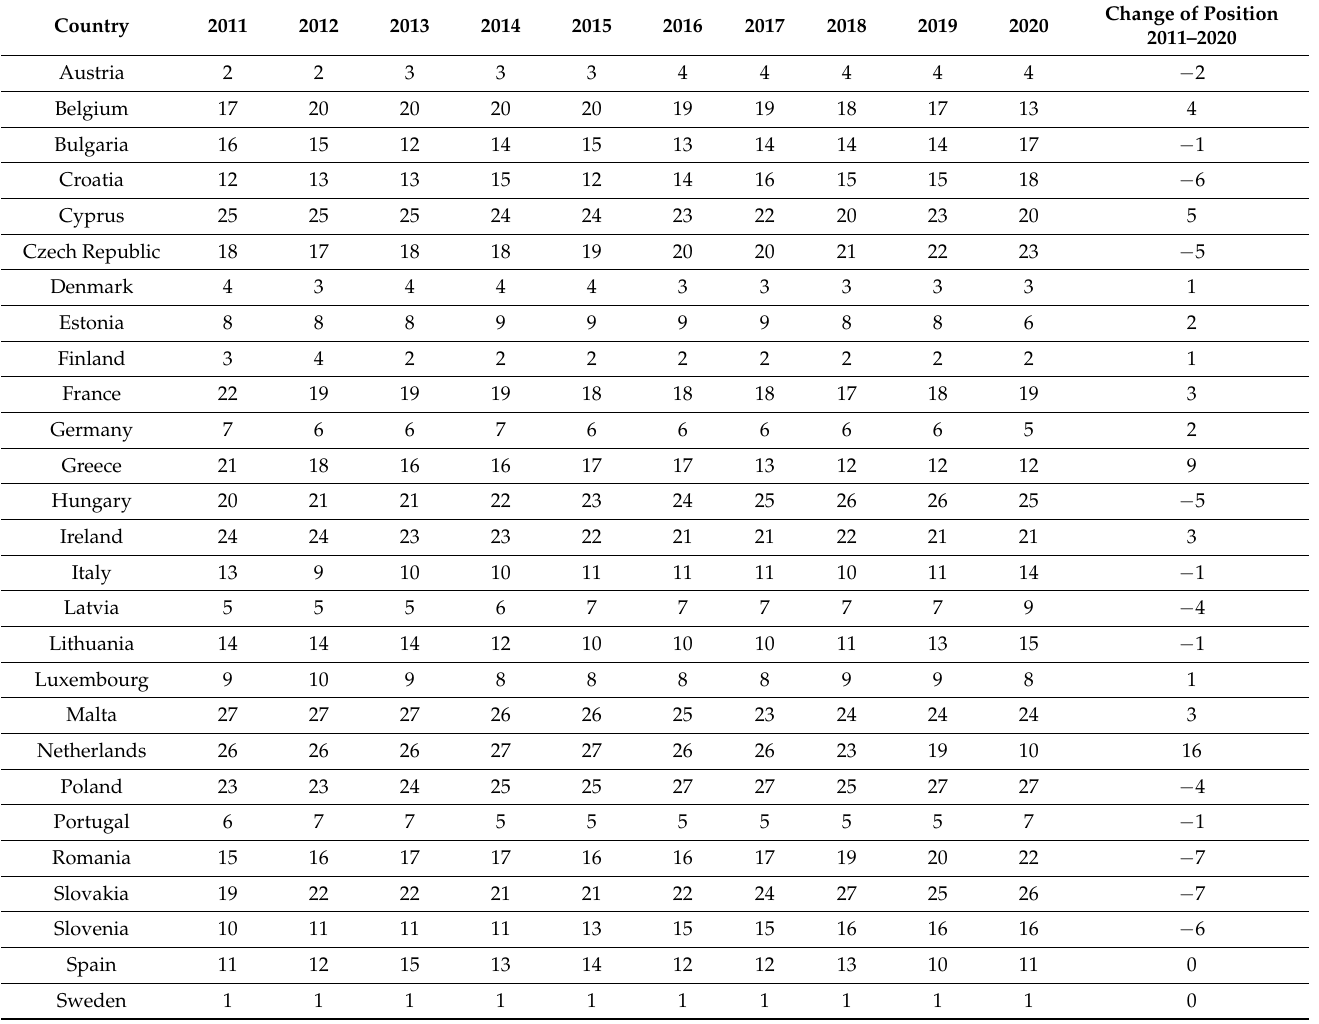
Table 5. Positions of EU countries in terms of the value of the synthetic measure indicating the level of renewable energy use from 2011 to